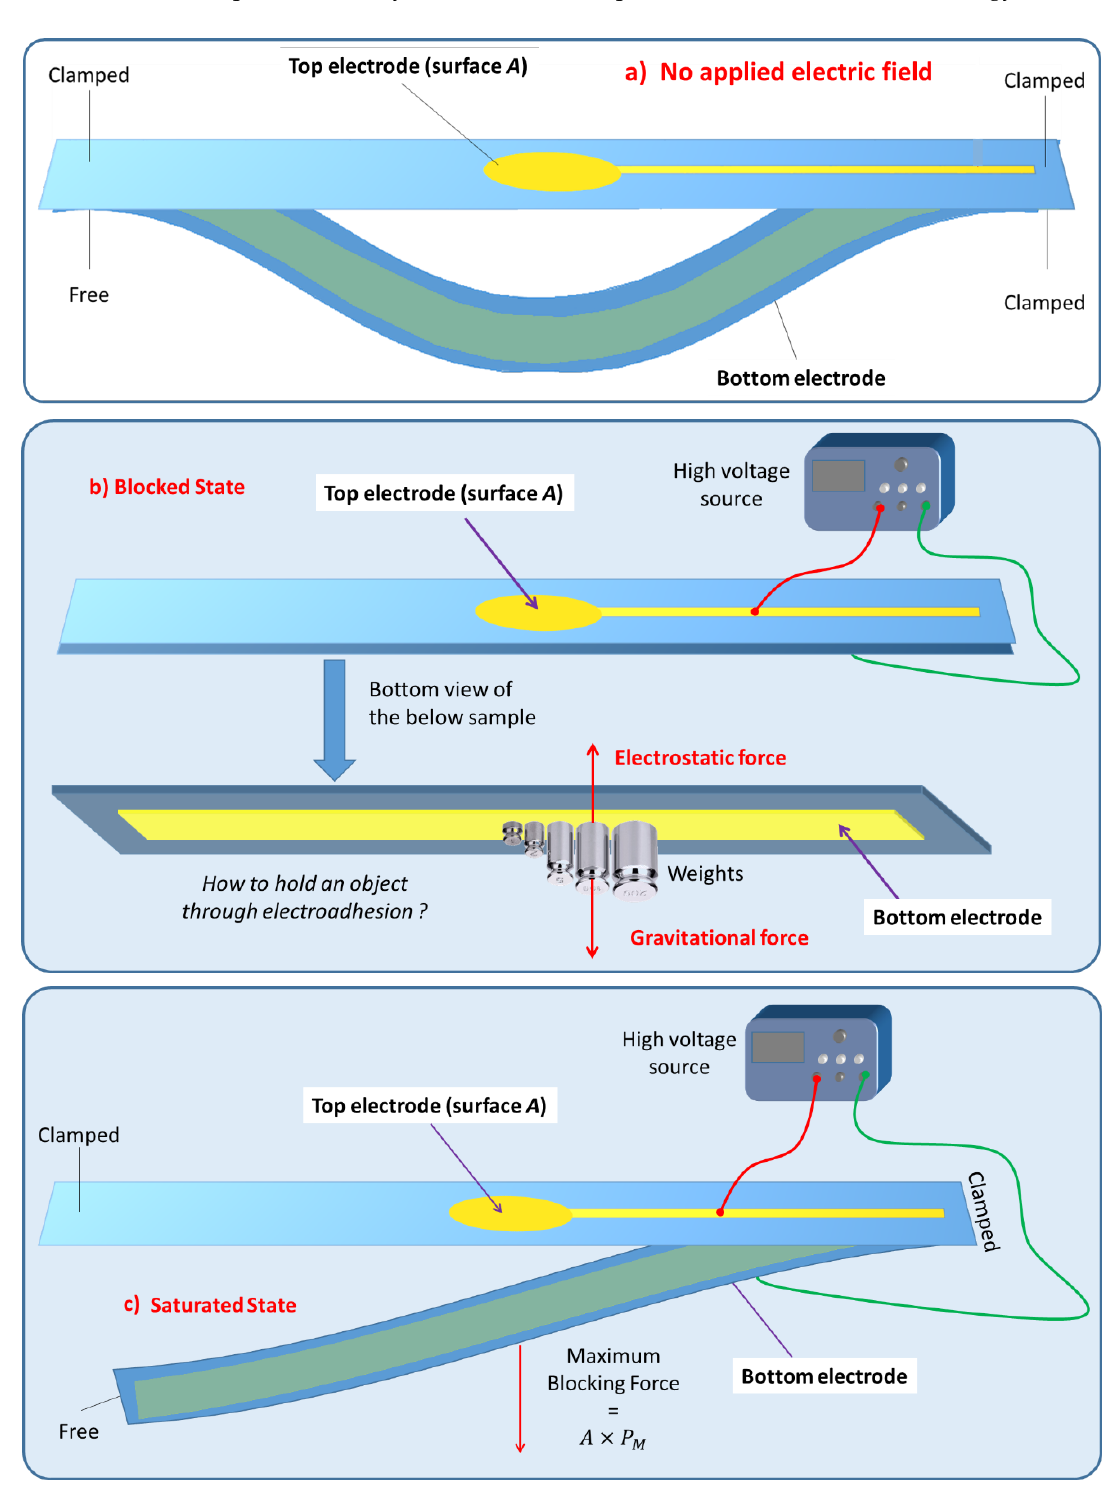
Figure 6. Experimental Bench for electroadhesion measurements. ( a ) Without electric field. ( b ) With electric field and in blocked state. ( c ) With electric field and in saturated state.